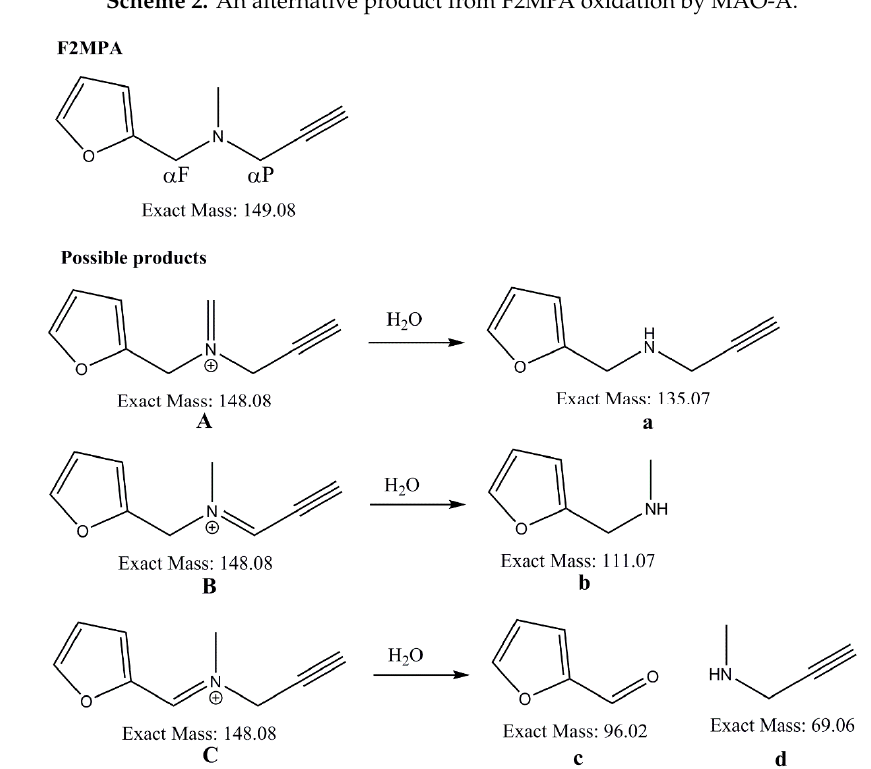
Figure 11. F2MPA partly reduces MAO-A but also forms a charge-transfer complex. Difference spectra were calculated by subtracting the spectrum of anaerobic MAO-A alone from that after incubation with 4. ( a ) Anaerobic F2MPA (2 mM) was added to anaerobic MAO-A (13.4 μ M) and spectra collected every 10 min for 2.5 h (spectra at 10 min and 2.5 h shown) and then every hour. ( b ) Time course for reduction of MAO-A (495 nm for bleaching of the FAD; 456 nm is isosbestic), adduct formation (400 nm) and formation of a charge transfer species (595 nm).